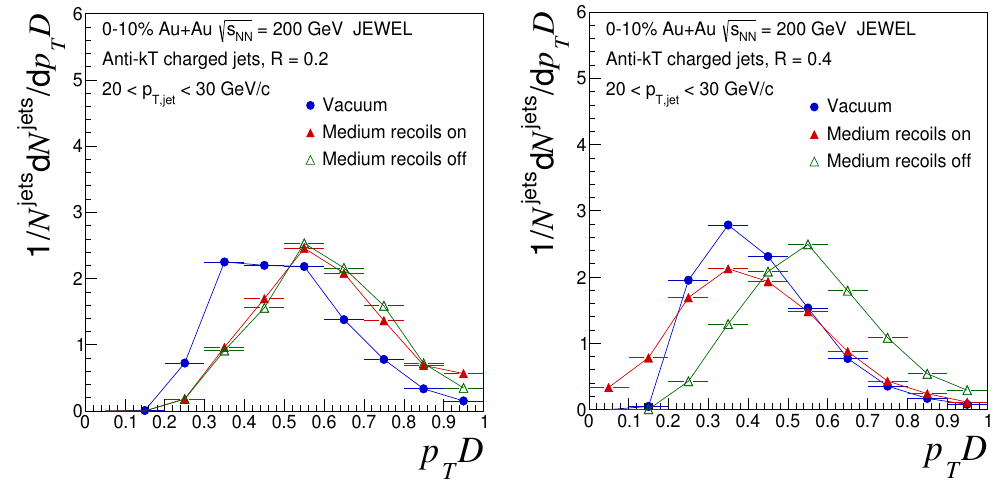
Figure 7. Momentum dispersion for jets with p T of 20–30 GeV/ c and R = 0.2 ( left ) and R = 0.4 ( right ) √ s NN = 200 in central Au+Au collisions at